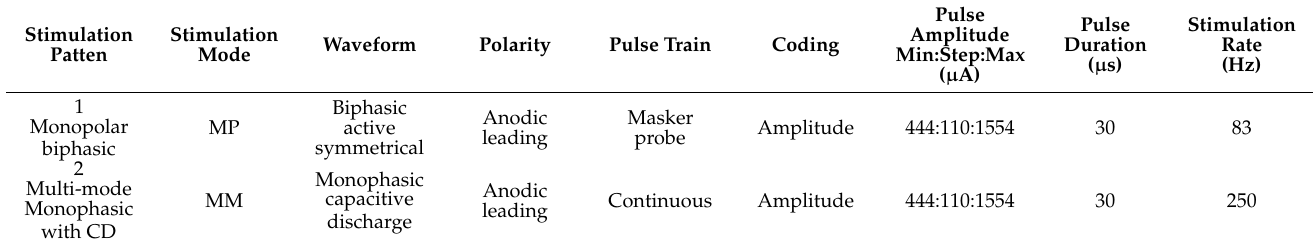
Figure 1. Schematic representation of different stimulation patterns used in this study. ( A ) Monopolar biphasic stimulation (stimulation pattern ST1) and ( B ) multi-mode monophasic stimulation with capacitive discharge (stimulation pattern ST2). Table 2. Stimulation parameters used to record EMG responses.